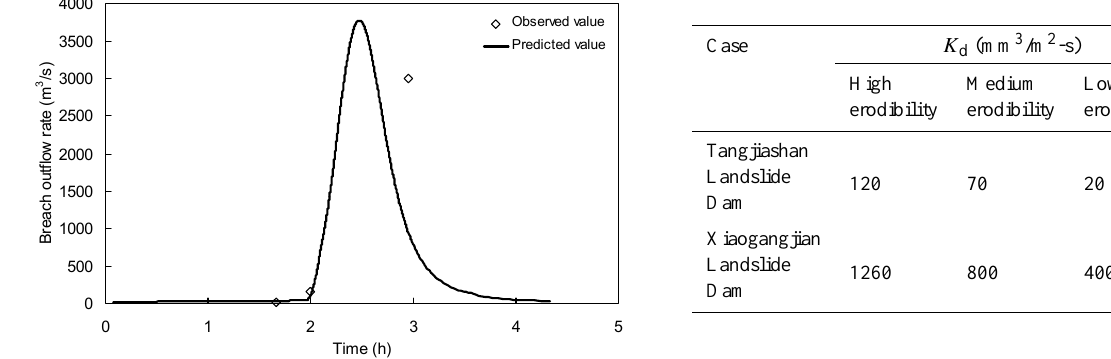
Fig. 12. Predicted and observed outflow hydrographs for the Xiaogangjian landslide dam (observed data from Ma and Zhou 2008).